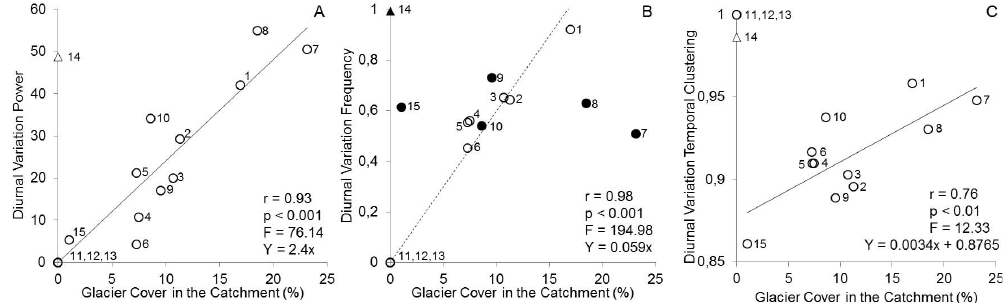
Fig. 7. Scatter plot of (A) diurnal variation power, (B) diurnal variation frequency, and (C) diurnal variation temporal clustering vs. the percentage of glacier cover in the catchment. In (B) black dots represent stream sites located in the Los Crespos catchment and open dots stream sites in the Antisana 14 Glacier catchment. The full regression line excludes site 14 in (A) , sites localized in the Los Crespos catchment (i.e., excludes black dots) in (B) and sites with no glacier cover in the catchment (i.e., excludes sites 11 to 14) in (C) . Sites numbers are indicated in the three